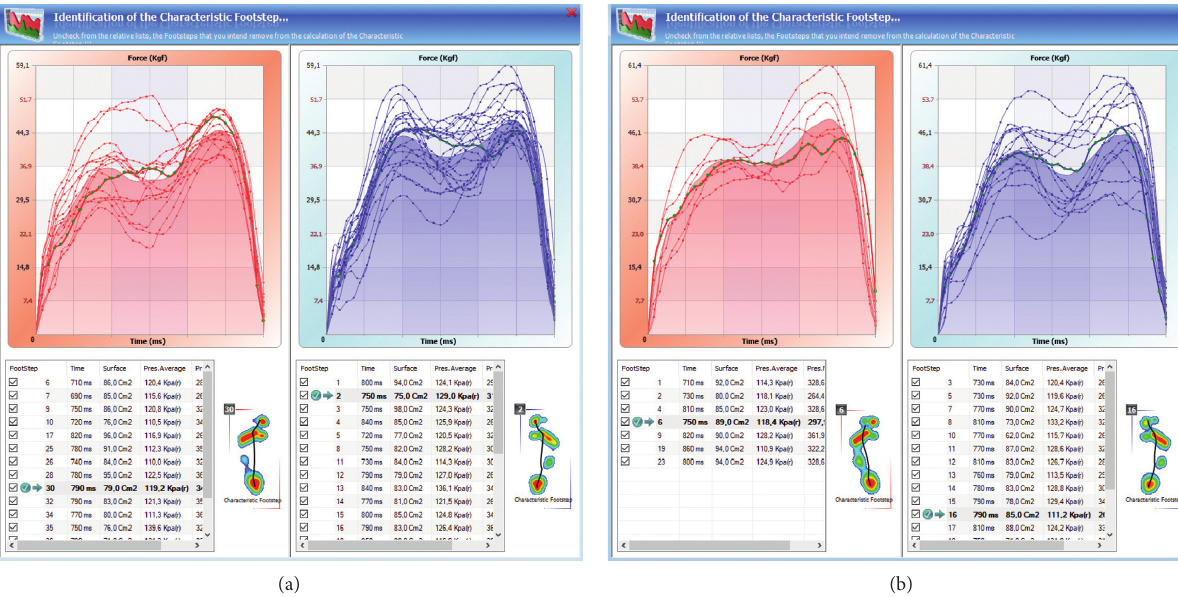
Figure 11: The exemplary graph presenting the results of strength distribution and time-space parameters during walking, measured at a therapeutic